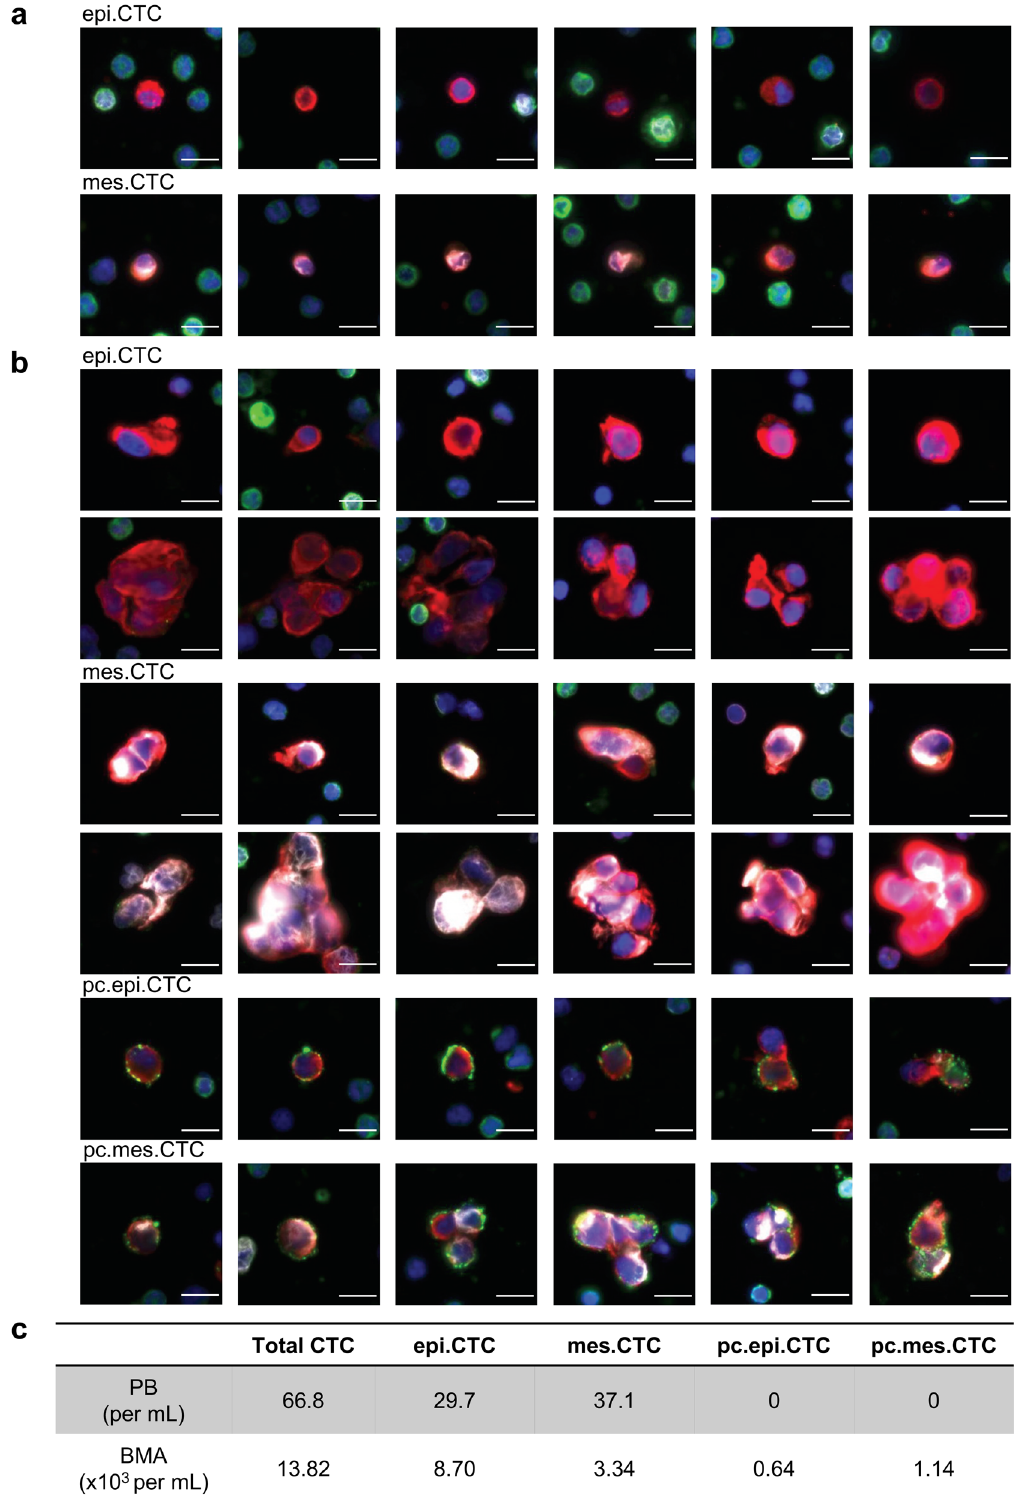
Fig. 2 CTC subtype and enumeration in the paired PB and BMA. a Immuno fl uorescence images of CTCs from PB sample. Scale bar: 10 μ m. b Immuno fl uorescence images of CTCs from BMA sample. Color coding: DAPI (blue); CK (red); VIM (white); CD45/CD31 (green). Scale bar: 10 μ m. c Enumeration of CTC subtypes in each test of PB and